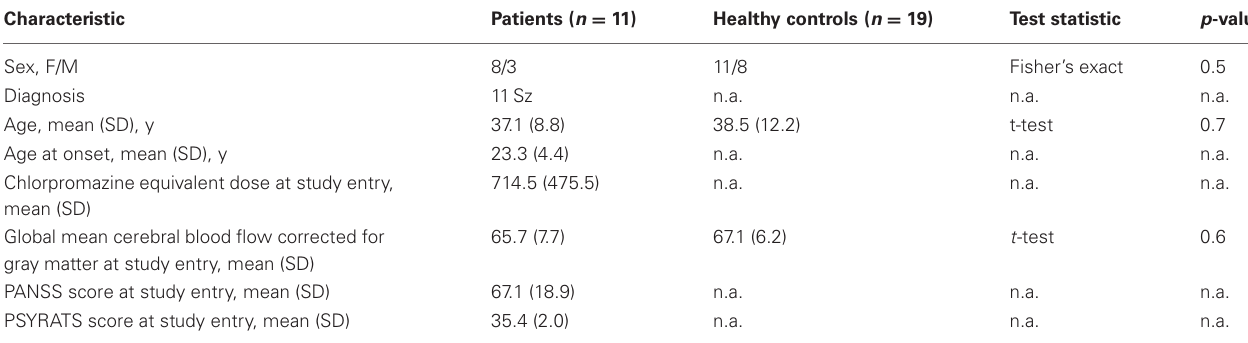
Table 1 | Subject characteristics of the patients ( n = 11) and healthy controls ( n = 19). Characteristic Patients ( n = 11)